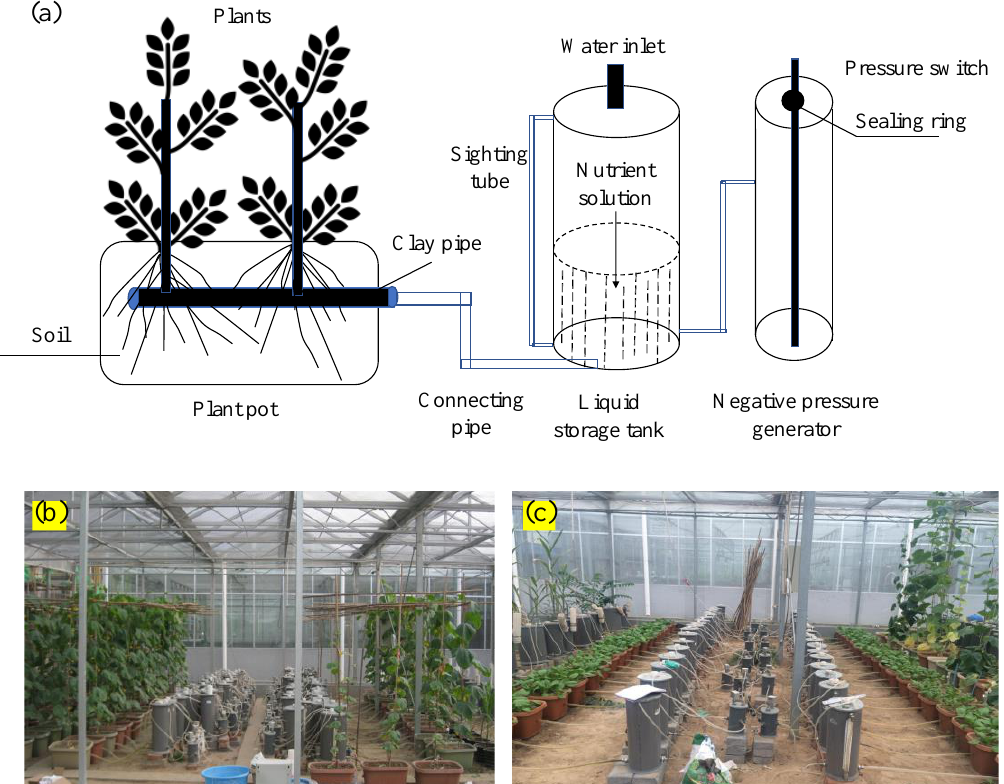
Figure 1. Schematic of plant growth when using a negative pressure irrigation system ( a ). Negative pressure irrigation applied to cucumber [3] ( b ) and rapeseed [9] ( c ) in greenhouse production.